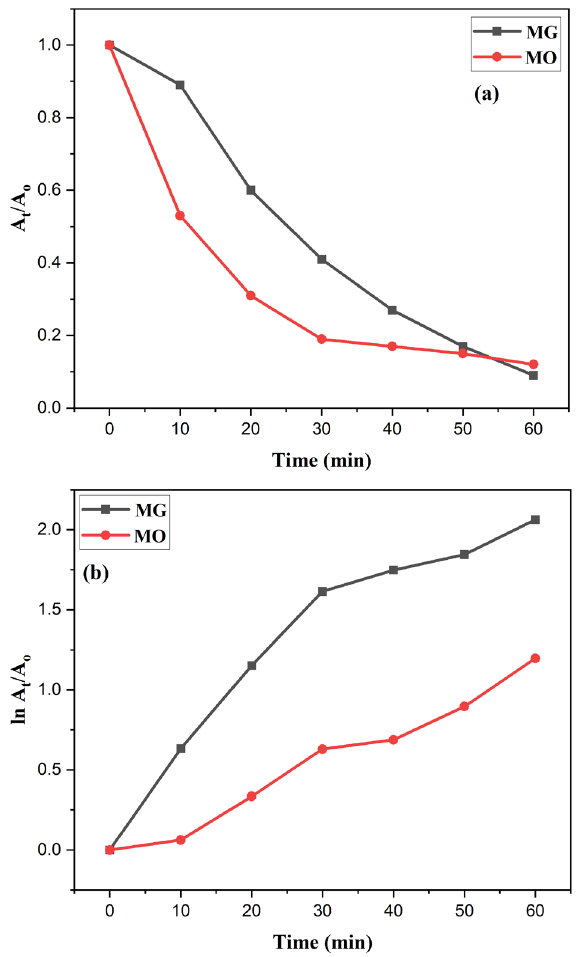
Figure 9. Kinetic results for dye degradation: ( a ) A/A o vs. time; ( b ) ln (A/A o ) vs. time.